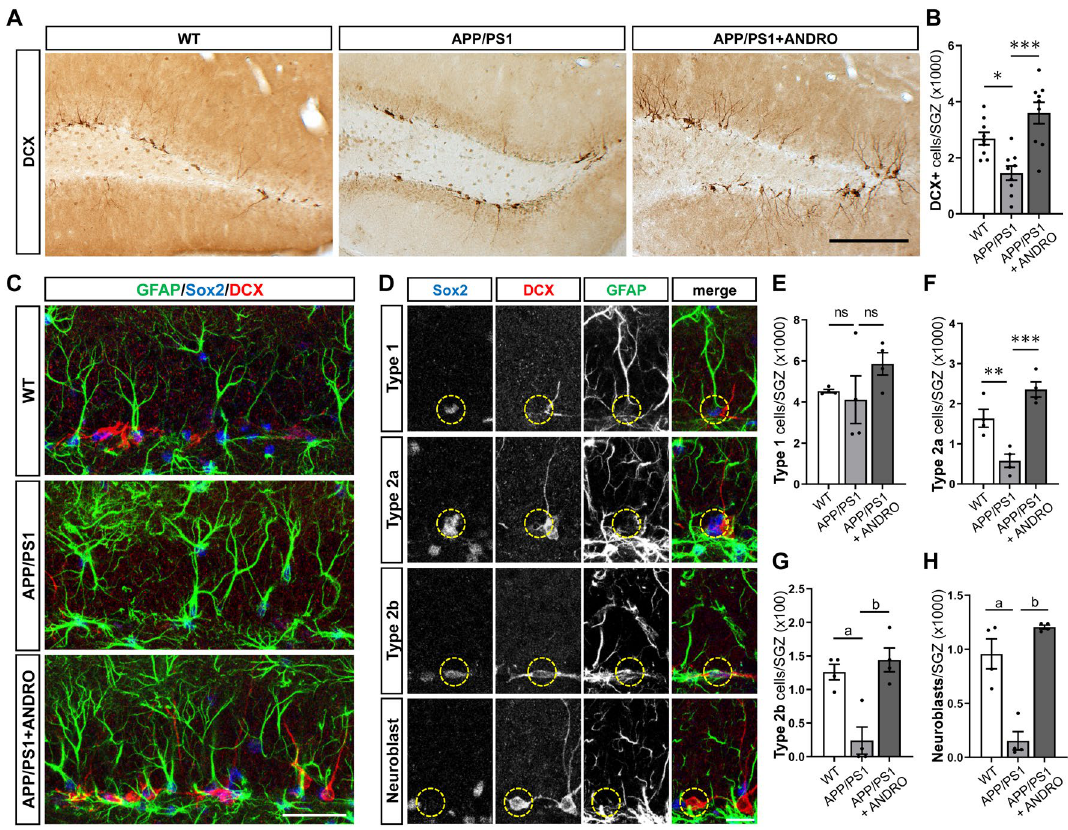
Figure 2. ANDRO increases neural precursor cells and immature neurons in the dentate gyrus of APPswe/ PSEN1ΔE9 mice. ( A ) Representative immunostaining of immature neuronal marker DCX in the dentate gyrus of control wild-type (WT), APPswe/PSEN1ΔE9 (APP/PS1) mice, and APP/PS1 mice treated with ANDRO. Scale Bar: 200 µm. ( B ) Quantification of the total number of DCX+ cells in the granular cell layer (GCL). Data are presented as mean ± SEM; WT = 9 mice; APP/PS1 = 9 mice; APP/PS1 + ANDRO = 9 mice. *p = 0.0204, ***p < 0.0001, one-way ANOVA followed by Bonferroni post-hoc test. ( C ) Immunostaining of GFAP, Sox2 and DCX in WT, APP/PS1 mice, and APP/PS1 mice treated with ANDRO. Scale Bar: 40 µm. ( D ) Representative immunostaining of type 1, type 2a, type 2b cells and neuroblasts in the dentate gyrus identified by immunostaining with GFAP, Sox2 and DCX, and by cell morphology. Scale Bar: 20 µm. ( E–H ) Quantification of the total number of type 1 ( E ), type 2a ( F ), type 2b cells ( G ) and neuroblasts ( H ) in the SGZ of WT, APP/ PS1, and APP/PS1 mice treated with ANDRO. Data are presented as mean ± SEM; WT = 4 animals; APP/PS1 = 4 animals; APP/PS1 + ANDRO = 4 animals. ns, non-significantly different. In ( F ), **p = 0.0098; ***p = 0.003. In ( G ), a p = 0.0062; b p = 0.0021. In ( H ), a p = 0.0006; b p < 0.0001; one-way ANOVA followed by Bonferroni post-hoc (Fig. 2D). These cells divide to generate type 2 neural progenitors that are rounded cells located in the SGZ that do not express GFAP and that are classified as type 2a or type 2b cells based on their neuronal commitment 38 . Type 2a cells are positive for Sox2 but not for DCX labeling, while type 2b cells are positive for both, Sox2 and DCX (Fig. 2D). Neuroblasts are positive for DCX but negative for GFAP and Sox2 labeling (Fig. 2D), are located